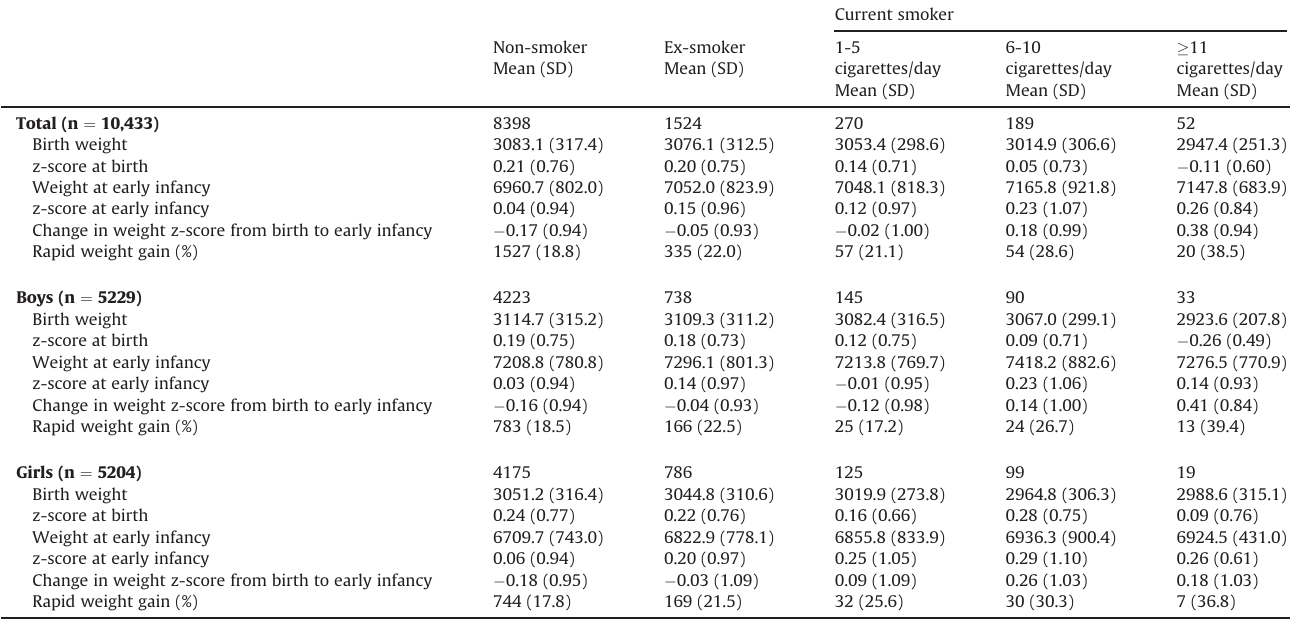
Table 2 Anthropometric data by sex and maternal smoking during pregnancy.